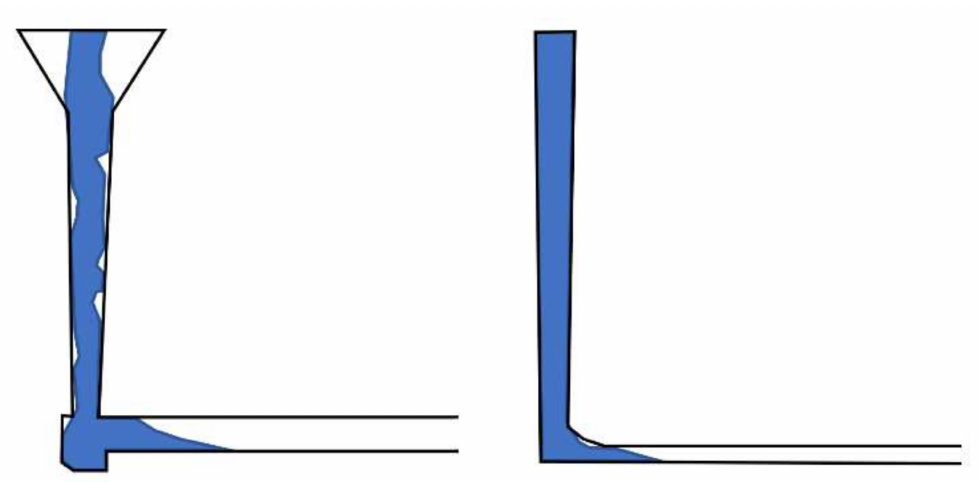
Figure 7. Sprue with improper ( left ) and proper ( right ) tapering [25].